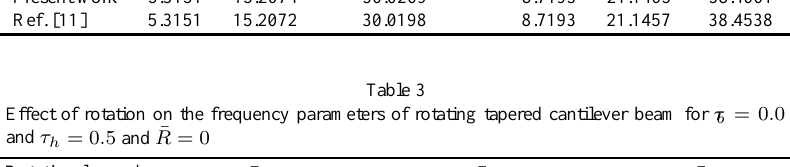
Table 2 The first three frequency parameters of a non-rotating cantilever wedge and cone beam with ¯ R = 0 Cantilever Wedge τ b = 0 . 0 , τ h = 1 . 0